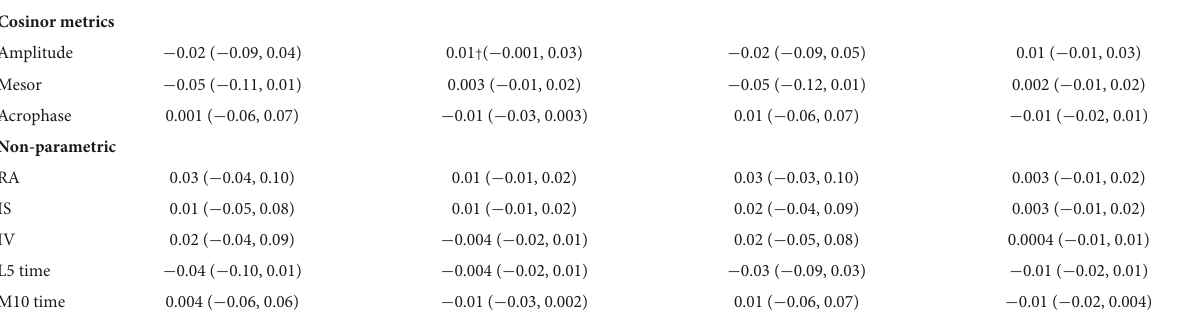
TABLE 8 Associations of circadian metrics with executive function, estimated beta (95% CI).